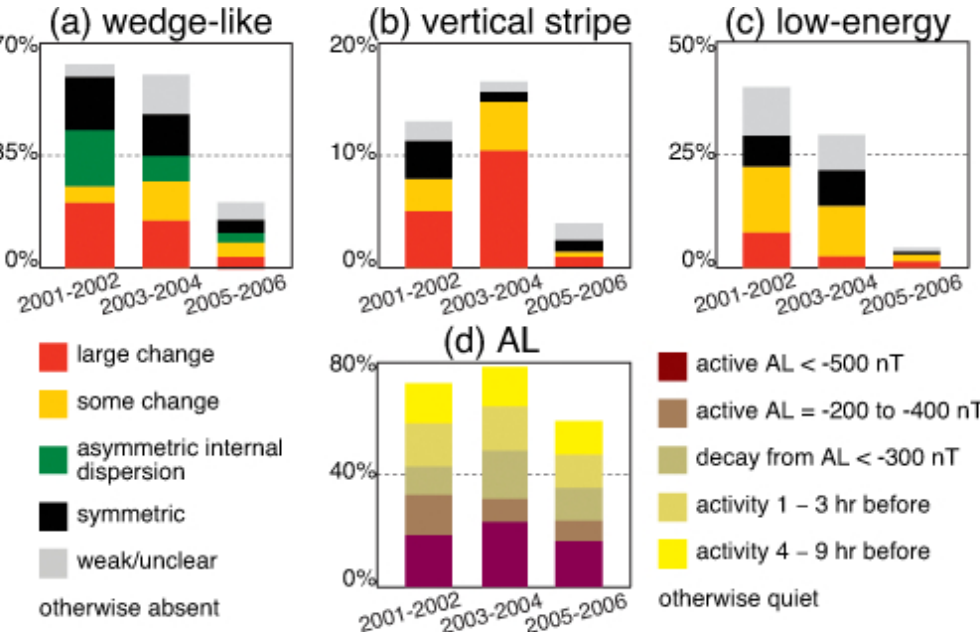
Fig. 3. Observation frequency (%) of (a) wedge-like dispersed ions, (b) vertical stripes, and (c) short bursts of low-energy ions during Cluster SC-4 perigee traversals, and (d) AL activity during all these traversals, for 2001–2002 (177 traversals), 2003–2004 (115 traversals), and 2005–2006 (202 traversals). Each ion signature is sub-classified by inbound–outbound difference (large change means one order of magnitude difference in the differential energy flux; some change means more than about a factor of 3 difference in the differential energy flux) or by the energy–latitude dispersion direction of the internal stripes (asymmetric with respect to the equator is shown by green). Symmetry means no significant change in the intensity or energy–latitude dispersion direction. The geomagnetic activity is classified by the current AL activity as well as the hours from the latest AL activity of | AL | > 200nT.